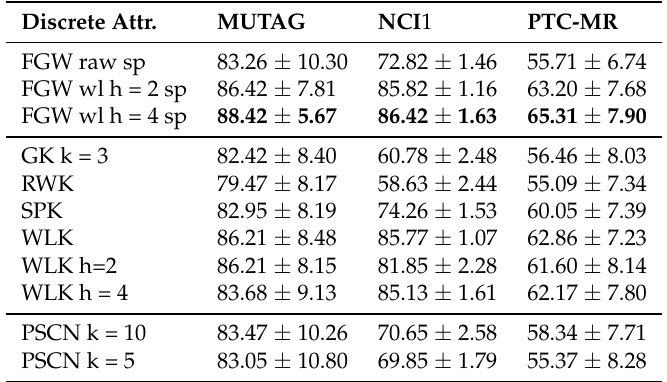
Table 2. Average classification accuracy on the graph datasets with discrete attributes. Discrete Attr.